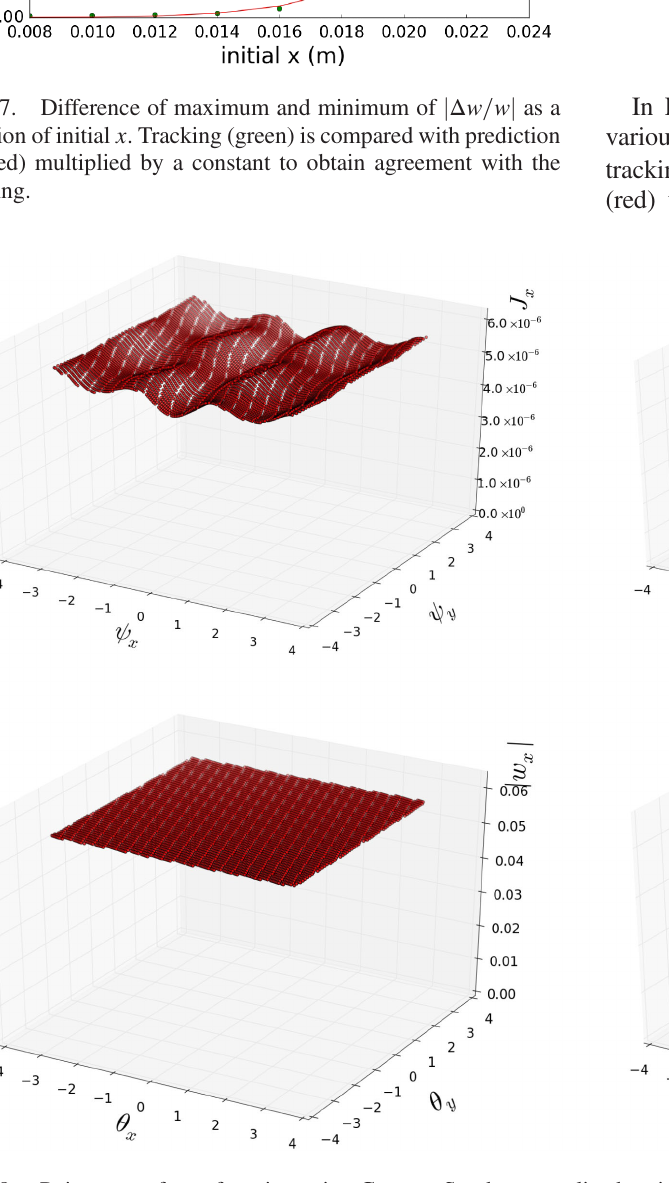
, ¯ z (top row) compared with new variables w x y , j w for all points are the same as a point generated from x 0 j y 0 j